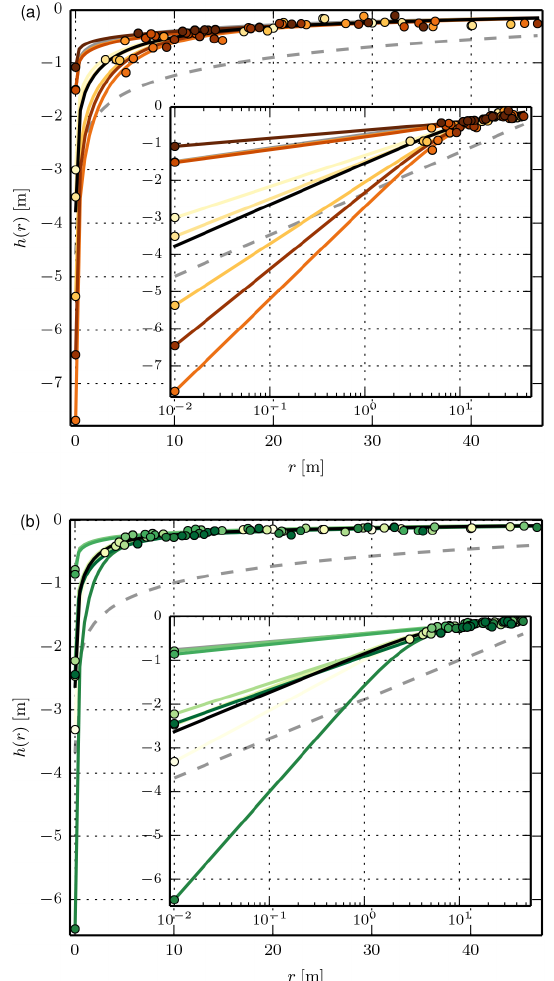
Figure 6. Simulated drawdown measurements (dots) and fitted ef- fective well flow solution h efw (r) (lines) for eight pumping tests within the heterogeneous transmissivity fields (a) D1 and (b) E1. Colours indicate the results for the individual pumping tests at PW 0 ,... , PW 7 (from light to dark). The black line denotes the ef- fective well flow solution h efw (r) fitted to all measurements jointly. Grey lines denote Thiem’s solution for ˆ T G (solid) and for ˆ T well (dashed). Statistical parameters are given in Table